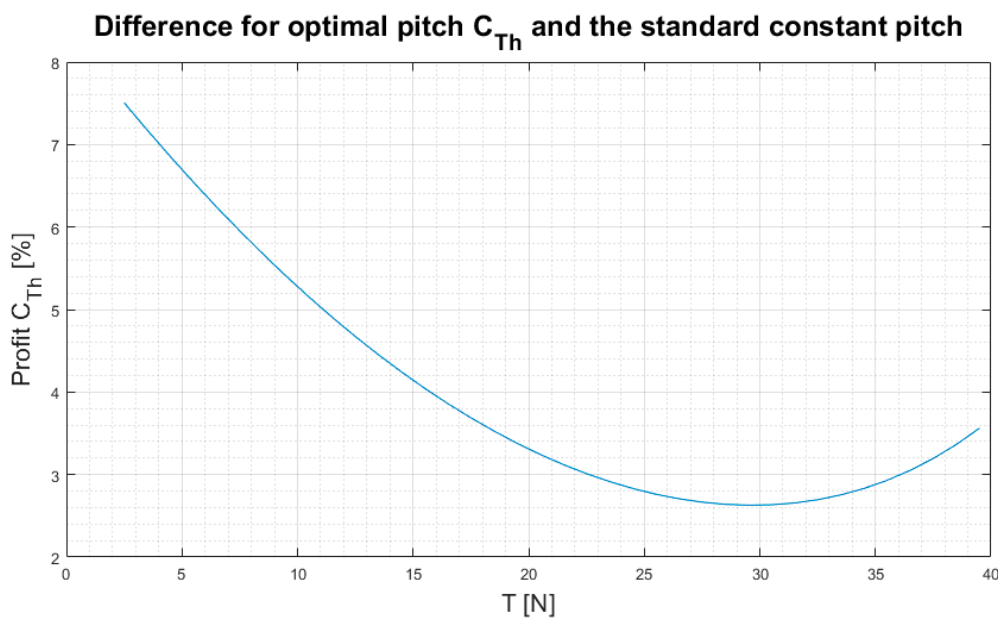
ff erence in C Figure 13. Difference in C Th for optimal pitch and standard constant pitch. Figure 13. Di Th for optimal pitch and standard constant